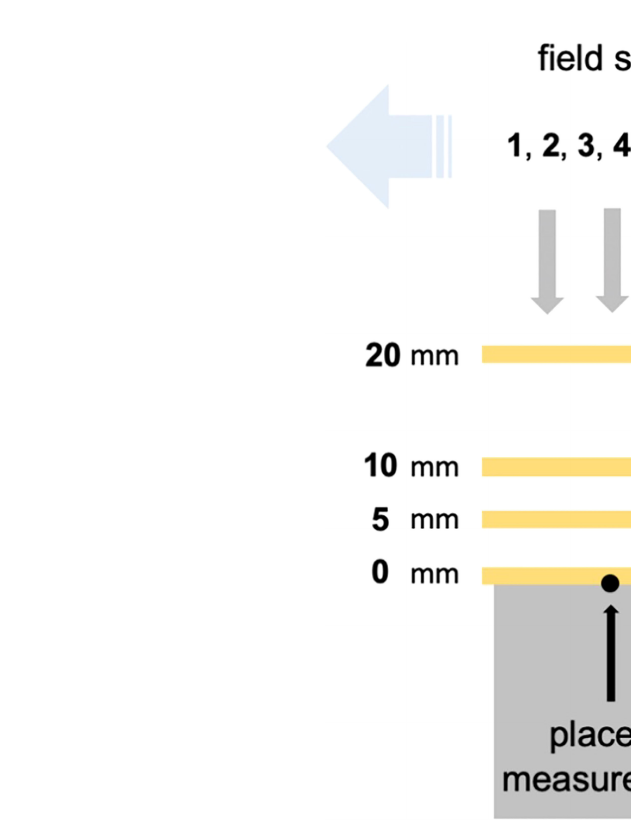
FIGURE 1 | Experimental setup to estimate the in fl uence of distance and fi eld size on dose